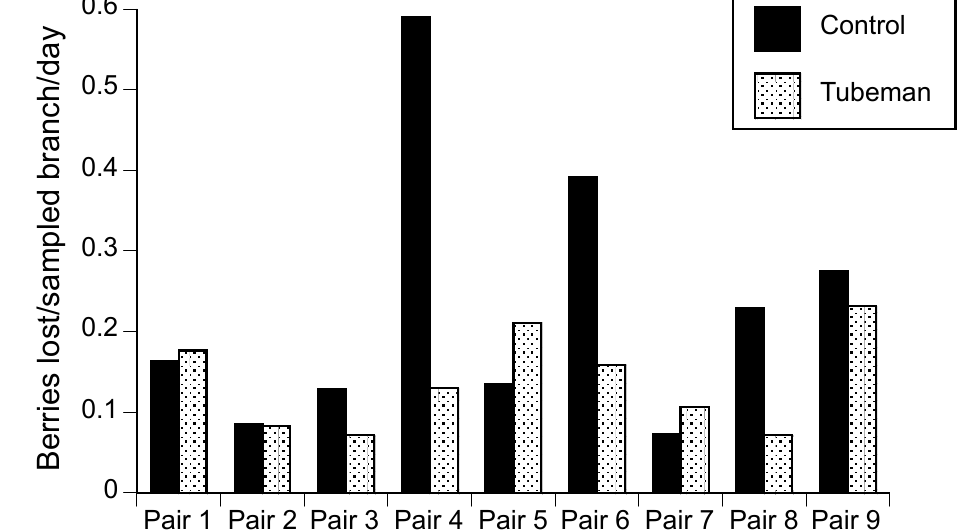
Figure 3. Blueberries per sampled branch per day lost to birds in control and tubemen blocks, 2013 and 2014.